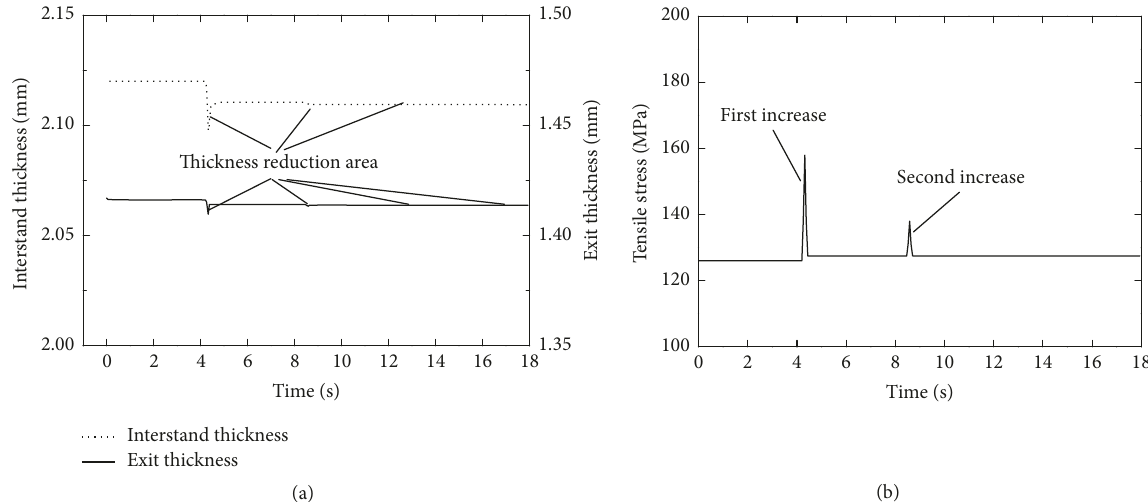
Figure 6: Thickness and tensile stress variations in the startup process with tension established by the exit stand: (a) thickness variation; (b) tensile stress